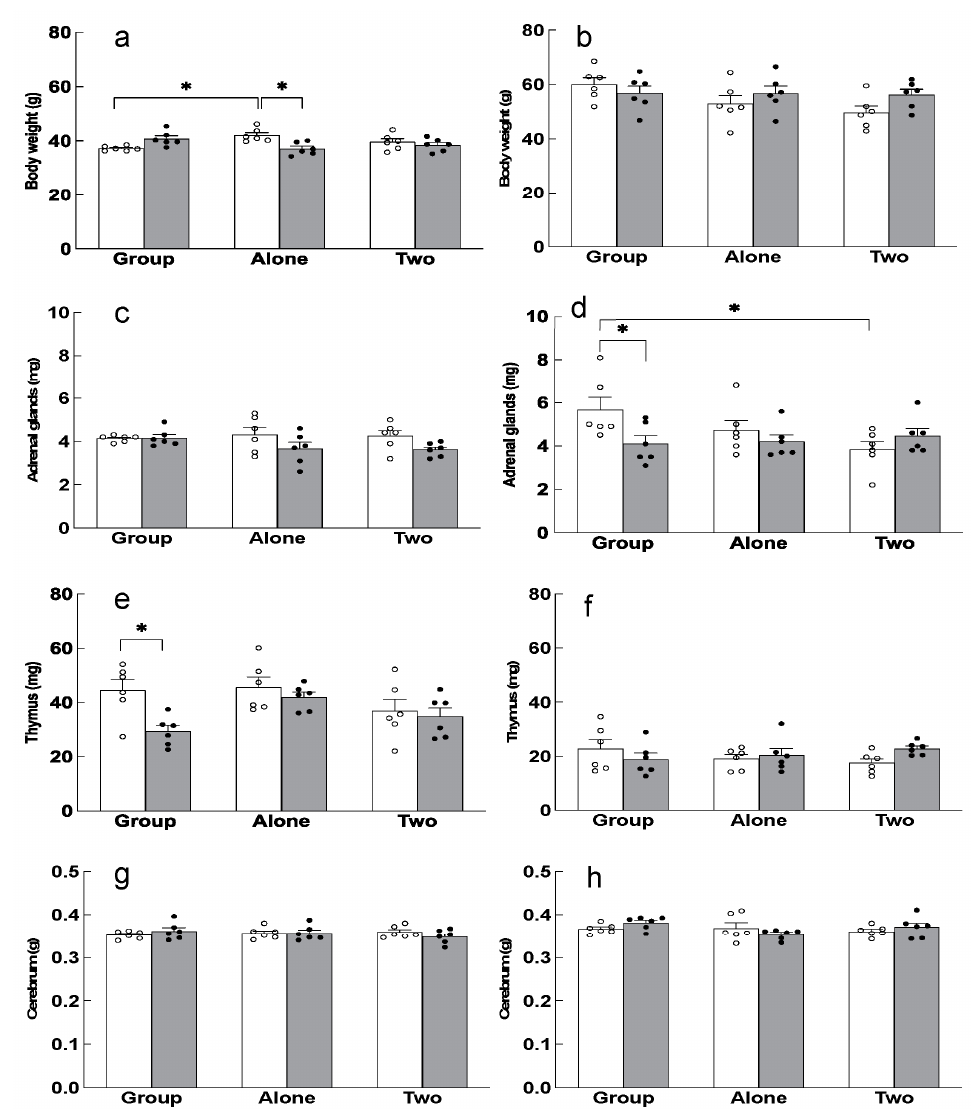
Figure 1. Housing conditions: group, single, and double.